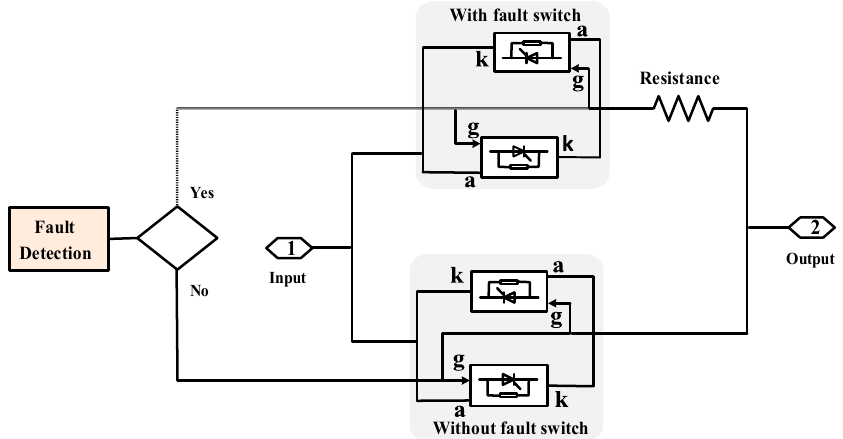
Figure 6. Crowbar circuit with controlled switches.